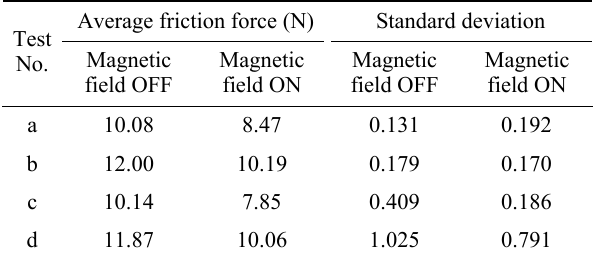
Table 3 Average friction force and SD of tests a–d of Fig. 7. Average friction force (N)